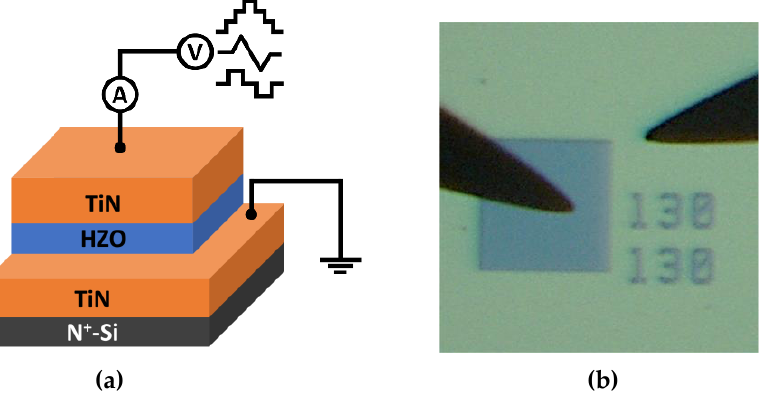
Figure 2. ( a ) The schematic diagram of the measurement setup, where the input voltage has DC, AC, and pulse mode. ( b ) The device pattern for measurement by optical microscope.